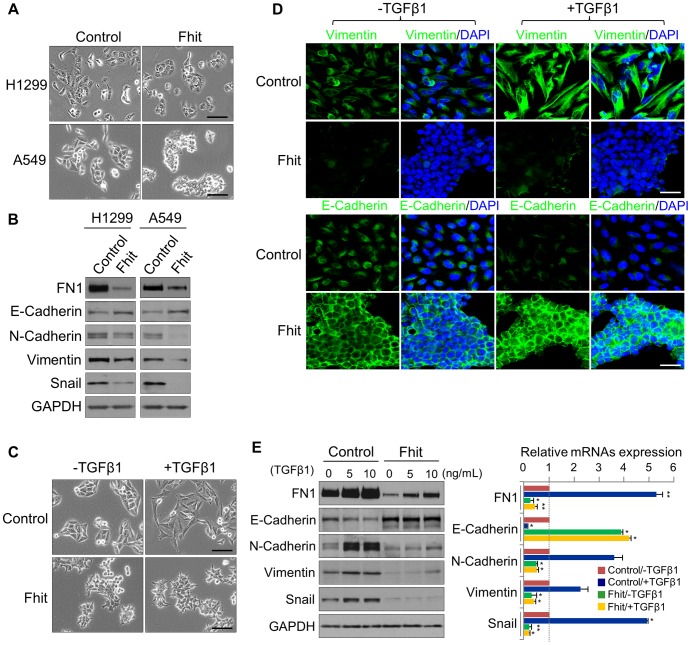
FHIT modulates EMT in NSCLCs through the suppression of EMT-related genes.(A), (B) Phase contrast images of FHIT-expressing or control A549 and H1299 cells, and Immunoblot analysis of EMT markers in both cell lines, respectively. Scale bar, 50 µm. (C), (D) Phase contrast and immunofluorescence images for Vimentin and E-cadherin staining in TGF-β1-induced A549 cells. DAPI staining was used to detect nuclei and merged with Vimentin and E-cadherin stained images. Scale bar, 50 µm (for brightfield images), 20 µm (for immunofluorescence images). (E) Immunoblot and qRT-PCR analyses of expression of EMT markers, Fibronectin (FN1), E-cadherin, N-cadherin, Vimentin and Snail, in response to TGF-β1 treatment of A549 cells with and without FHIT expression. RT-qPCR values were normalized to the housekeeping gene GAPDH. Experiments were performed three times and the data are presented as the mean ± s.d. *P<0.05 and **P<0.01 by Student's t-test.